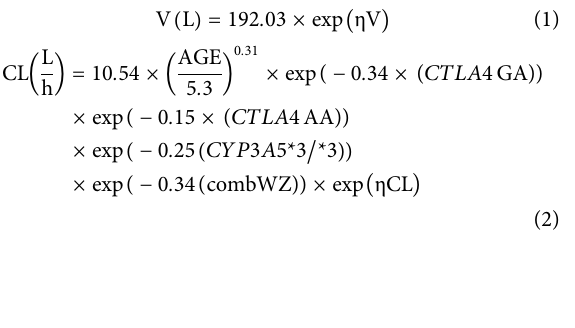
Table 3. The typical values of the population for CL and V were 10.54 L · h − 1 and 192.03 L, respectively.